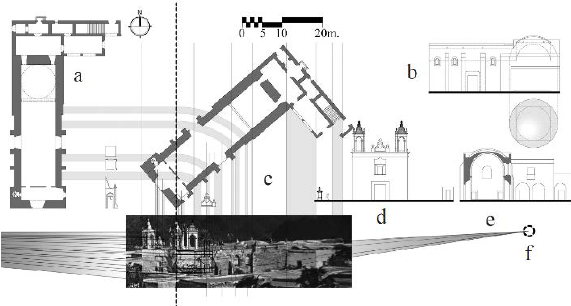
Figure 1. Fragment of the Topographic Map of the City of Figure 2. Photogrammetric analysis of the Jesús María temple, Mérida (Díaz and Salazar, 1864-1865), depicting the central from the Catalogue in subsections (a, e); photograph from the core of Mérida. According to the original nomenclature, "a" Photo Library "Pedro Guerra" of the Autonomous University of corresponds to the Cathedral Church; "B", the Imperial Yucatán (1883 ca.) (c); new orthogonal projections (d, b) Commissariat; "E", Jesus church and "l" the Jesús María temple. obtained by geometric deduction from the original “perspective Scale in Castilian Canes. The overlapping of the plan from the rays” (f). Catalogue of Religious Constructions of the State of Yucatán (México et al.,1945) with the Topographic Map evidences discrepancy in both the lot and the location of the building. An important feature is the absence of the Virgin’s Dressing Room on the north side of the building (staircase access), which does record the 1931 survey.